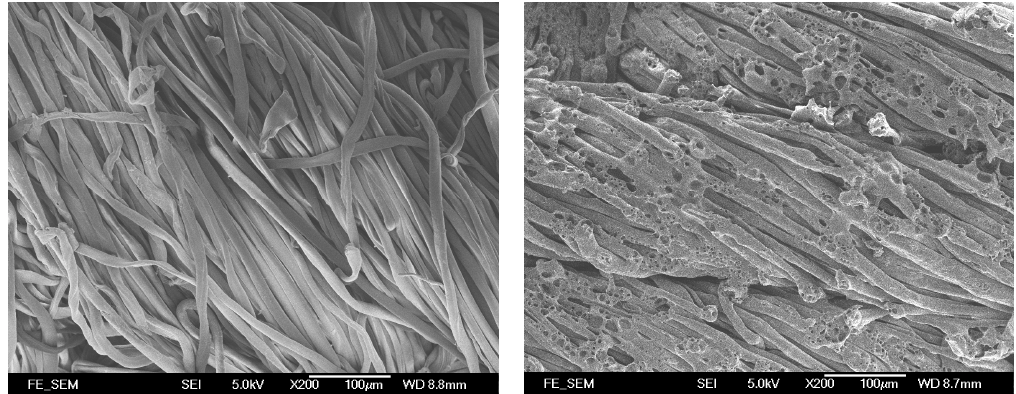
Figure 2. Morphological feature (200×) of control cotton fabric ( left ) and laser-treated cotton fabric with variables of 52 dpi/120 µs ( right ).